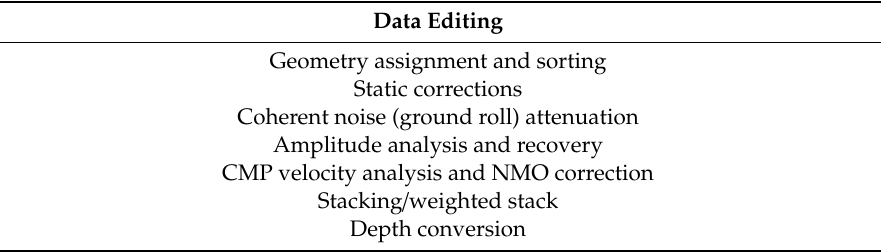
Table 2. Processing flow applied to reflection seismics’